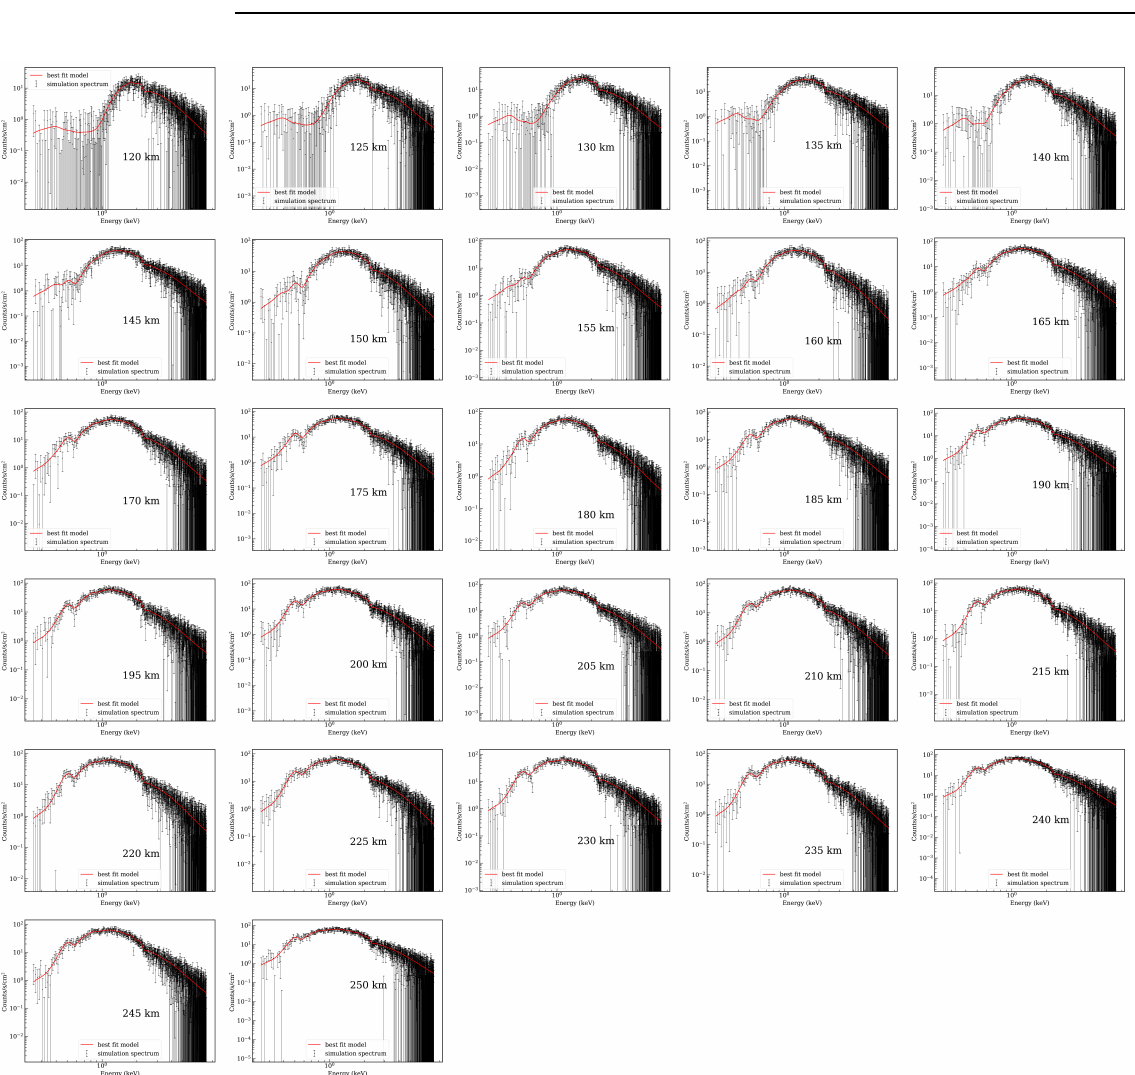
Figure 3. Comparison of the best fitting energy spectrum model and energy spectrum simulation data in the altitude range of 120–250 km. The black dots with error bars represent the simulation data, and the solid red lines represent the best fit model. It is found that the best fit is visually in good agreement with the simulation